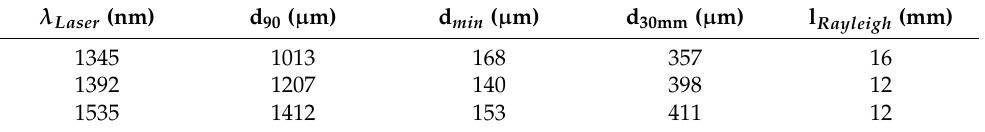
Table 3. Beam parameters of the TDLAS laser beams. λ Laser is the laser wavelength, d 90 is the 90% beam diameter before the lens, d min is the beam waist at the burner center, d 30mm is the beam diameter at the burner edge and l Rayleigh is the characteristic Rayleigh length. λ Laser (nm) d 90 ( µ m) d min ( µ m) d 30mm ( µ m) l Rayleigh (mm) 1345 1013 168 357 16 1392 1207 140 398 12 1535 1412 153 411